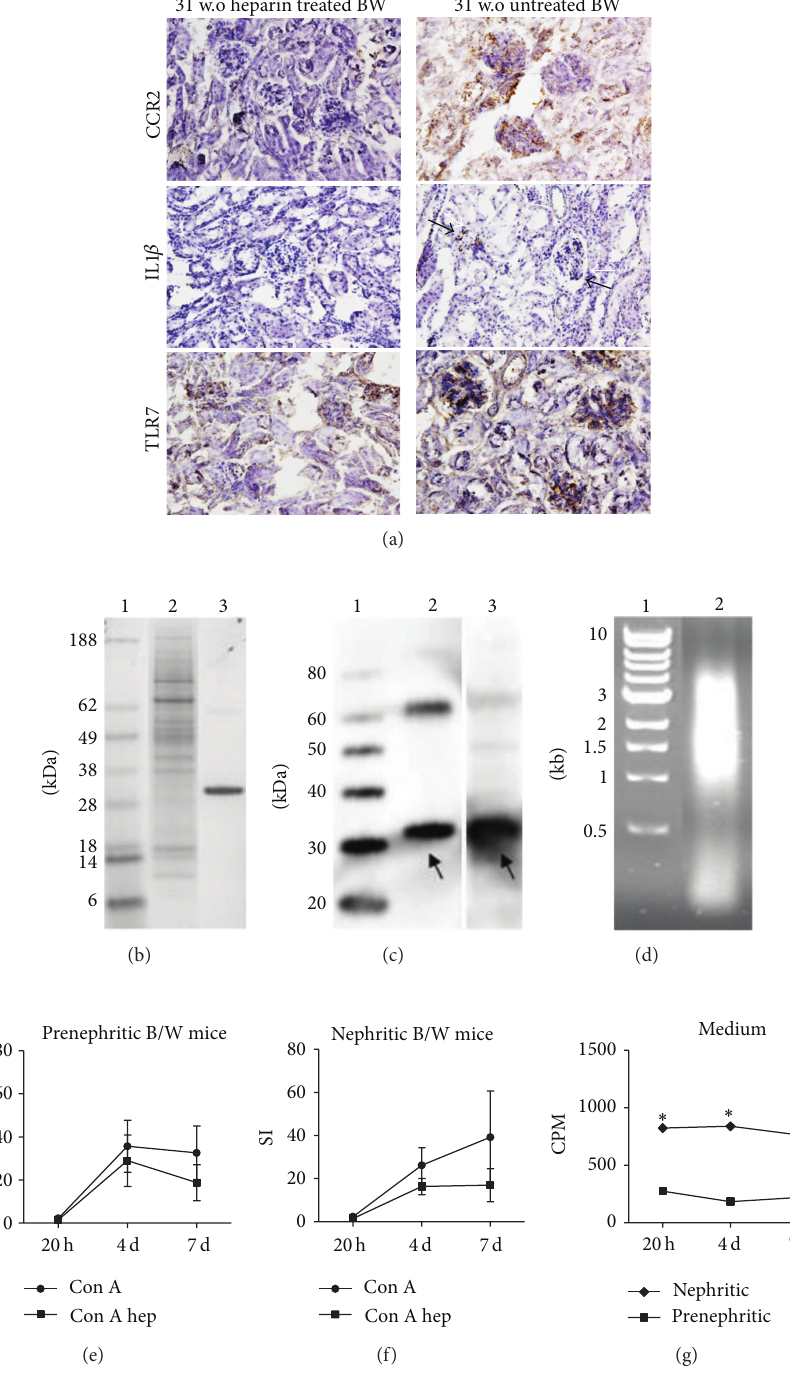
Figure 3: Characterization of nucleosomes used in this study and spontaneous splenocyte proliferation. Immunohistochemistry analysis detecting CCR2, IL1 𝛽 , and TLR7 protein expression in kidneys of 31 w.o heparin or untreated B/W mice (a). SDS PAGE of nucleosomes and HMGB1 used in cell culture stimulations ((b), lane 1: MW standard, lane 2: nucleosomes (3 𝜇 g measured as DNA), and lane 3: HMGB1 (1 𝜇 g)). Western blot showing HMGB1 (arrows) in nucleosomes purified from A31 cell line ((c), lane 1: MW standard, lane 2: HMGB1 (0.1 𝜇 g), and lane 3: nucleosomes (2 𝜇 g measured as DNA)). Agarose gel electrophoresis of nucleosomes showing a distribution of nucleosome sizes ((d), lane 1: MW standard, lane 2: nucleosomes (3 𝜇 g measured as DNA)). Stimulation index (SI) of cells from prenephritic mice (e) and